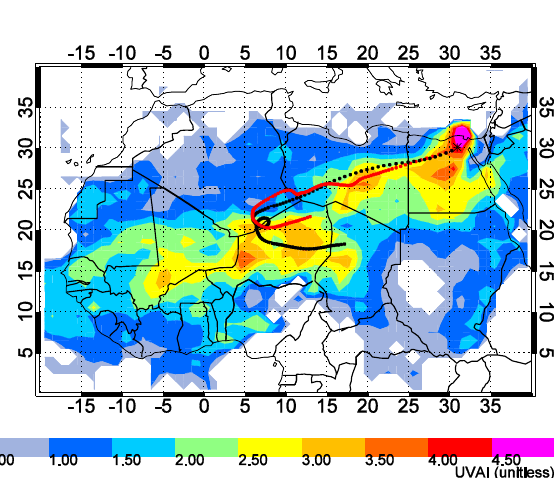
Fig. 8 OMI UVAI image over North Africa on 17 April 2007. The dotted lines are the HYSPLIT 689 Fig. 8. OMI UVAI image over North Africa on 17 April 2007. backward trajectories starting from Cairo on 17 April 2007 10.00 UTC for 5 days, the red 690 The dotted lines are the HYSPLIT backward trajectories starting from Cairo on 17 April 2007 10:00UTC for 5days, the red trajec- trajectory starts at height of 3000 m AGL and the black trajectory starts at height of 4000 m 691 tory starts at height of 3000ma.g.l. and the black trajectory starts at above AGL. 692 height of